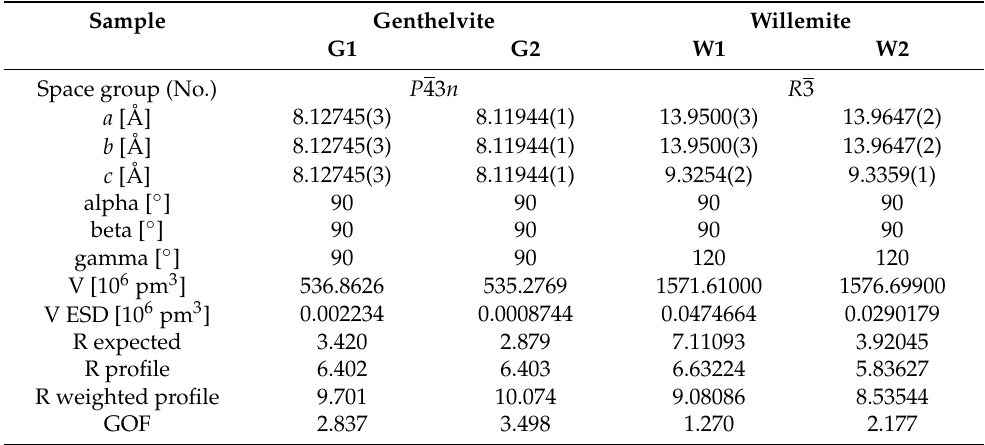
Table 3. Crystal data and data collection information for genthelvite and willemite